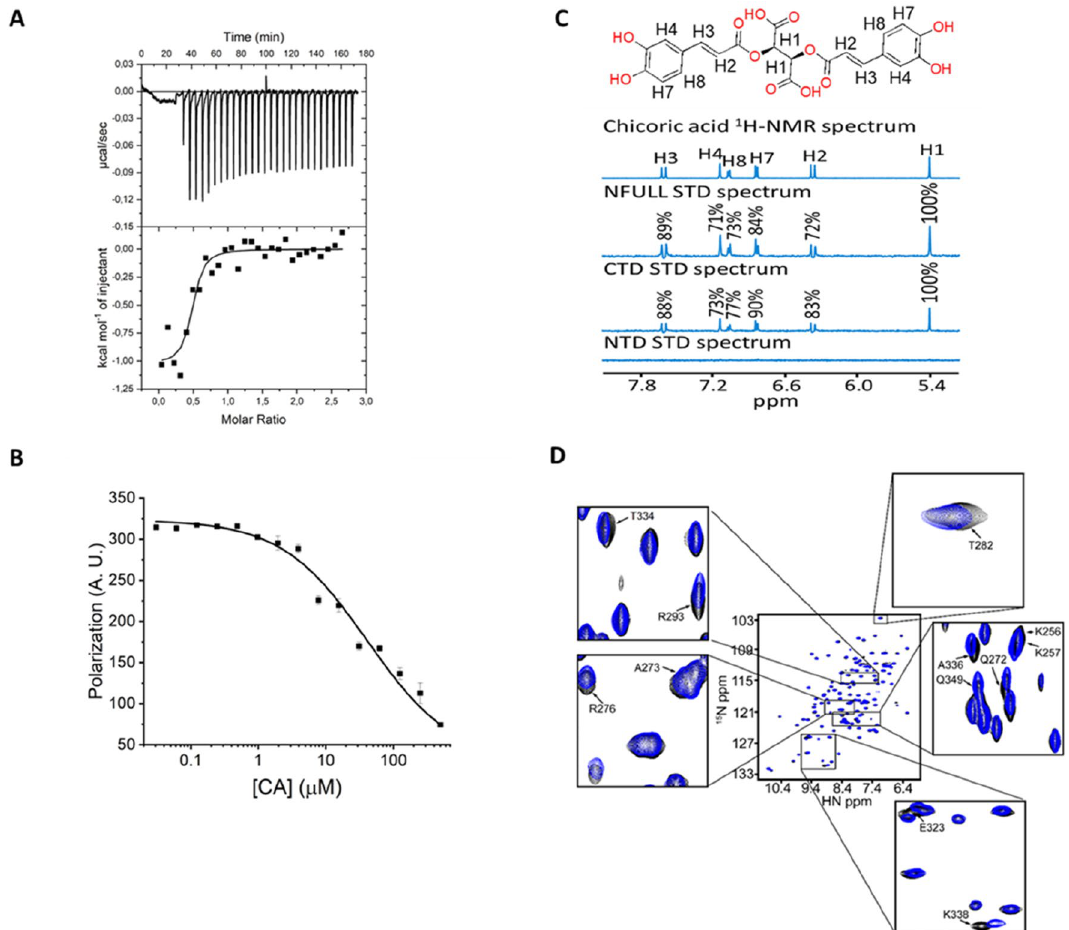
Figure 3. Chicoric acid (CA) is a nanomolar N-protein affinity ligand that binds the CTD and promotes dissociation of the N protein-RNA1 complex. ( A ) ITC assay showing the thermodynamic parameters of interaction between the N protein and CA. The free N protein (20 µM) was titrated against CA (250 µM). The data were fitted to the One Set of Site model, resulting in the following thermodynamic parameters: association constant (K A ) = 2.27E6 1.3E6 M -1 (K D = 0.25 ± 7.9 E-9 µM); binding enthalpy change (ΔH) = − 953.2 ± 104.4 cal/ mol and binding entropy change (ΔS) = 27.0 ± 1.0 cal/mol/deg. The isotherm is representative of three replicates and the values reported are average and standard deviation of the three independent experiments. ( B ) Dissociation curve showing that CA promotes the dissociation of previously formed N protein-RNA1 complex with a K D value of 41.1 ± 11.7 µM. ( C ) One-dimension 1 H-STD NMR spectra of CA in the presence of free N protein (full-length), CTD or NTD. The relative degree of saturation of each hydrogen atom of CA is mapped onto each spectrum and normalized by hydrogen H1. ( D ) 1 H- 15 N-HSQC spectra of free 15 N-CTD in the absence (black signals) or presence (blue signals) of CA in a 1:1 protein:CA ratio. Assigned peaks were based on the BMRB entry 50,518. Highlighted peaks correspond to signals that changed by more than 0.02 ppm using the deviation equation Δδ( 15 N + 1 H) = [(Δδ 15 N/10) 2 + (Δδ 1 H) 2 ] 1/2